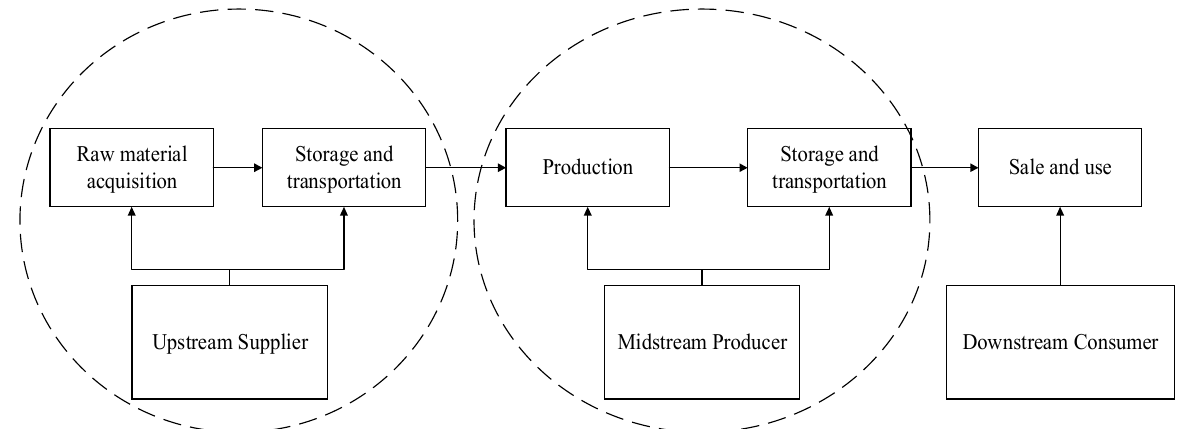
Figure 3. General framework of the energy industry chain.